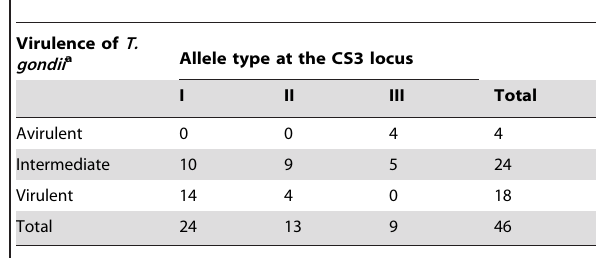
Table 4. Association between the allele type at the CS3 locus of Toxoplasma gondii isolate and retinochoroidal lesions in newborns with congenital toxoplasmosis (p . 0,05).